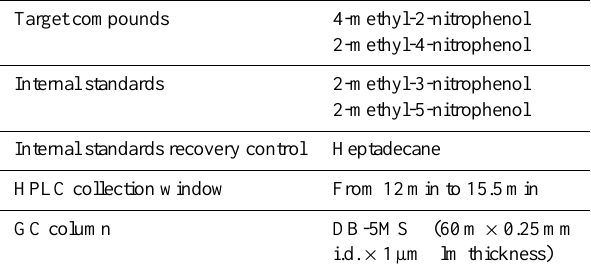
Table 1. Target compounds, internal standards, internal standards recovery control, HPLC collection windows and GC column used for methylnitrophenol analysis.